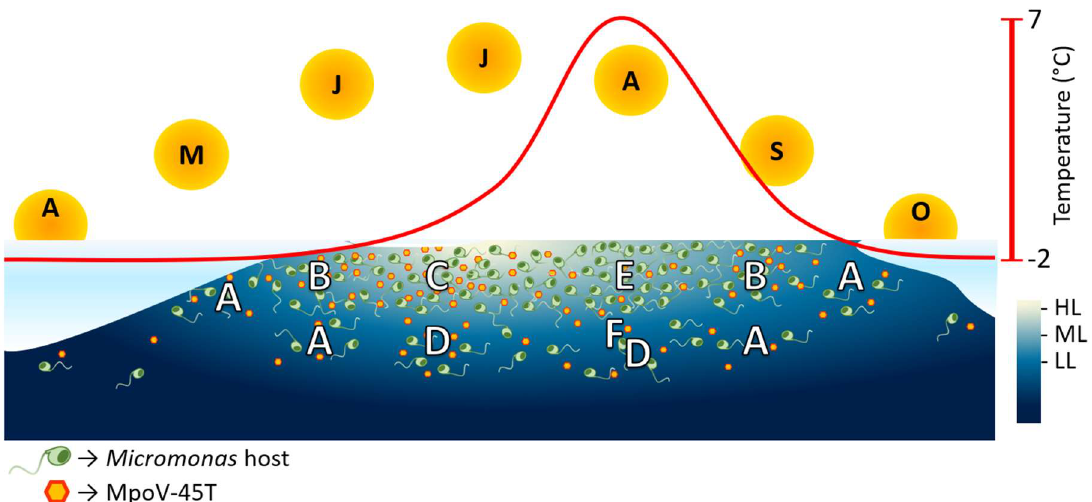
Figure 5. The predicted response of M. polaris host and MpoV-45T populations during the arctic productive season. The letters inside the symbolic suns represent the months (April to October) and the red line represent the change in temperature of the surface ocean along the season. The symbols in the water column represent the predicted spatiotemporal dynamics of the algal host and its virus MpoV-45T under influence of irradiance and temperature (based on our results). The white letters in the water column represent the possible spatiotemporal occurrences of the conditions referred to in the discussion (A–F). LL, ML, and HL stand for low, mid and high light intensity (5, 60, and 160 μmol quanta m -2 s -1 ). Supplementary Materials: Figure S1: Temporal dynamics of cellular forward scatter of non-infected controls and MpoV-4T infected Micromonas polaris , Figure S2: Temporal dynamics of cellular side scatter of non-infected controls and MpoV-4T infected Micromonas polaris , Figure S3: Temporal dynamics of cellular chlorophyll red autofluorescence of non-infected controls and MpoV-4T infected Micromonas polaris , Figure S4: Temporal dynamics of cellular reactive oxygen species of non-infected controls and MpoV-4T infected Micromonas polaris . Figure S5: Temporal dynamics, during two independent experiments, of algal abundances, photosynthetic efficiency, cellular characteristics, percentage of dead cells and MpoV-45T abundances for MpoV-45T infected Micromonas polaris RCC2258 cultured at 7 °C with a 16:8 h L:D and under ML light intensity (60 μmol quanta m - 2 s -1 ). Table S1: Statistical two-way ANOVA of treatments with interaction terms affecting M. polaris growth and cellular characteristics. Table S2: Statistical two-way ANOVA of treatments with interaction terms affecting infection dynamics for M. polaris host and MpoV-45T.